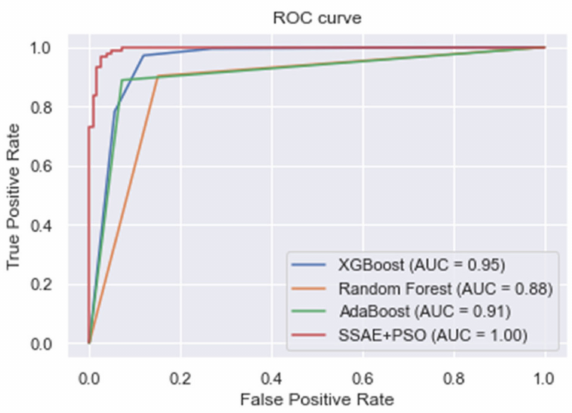
Figure 2. ROC curve of the classifiers using the Framingham